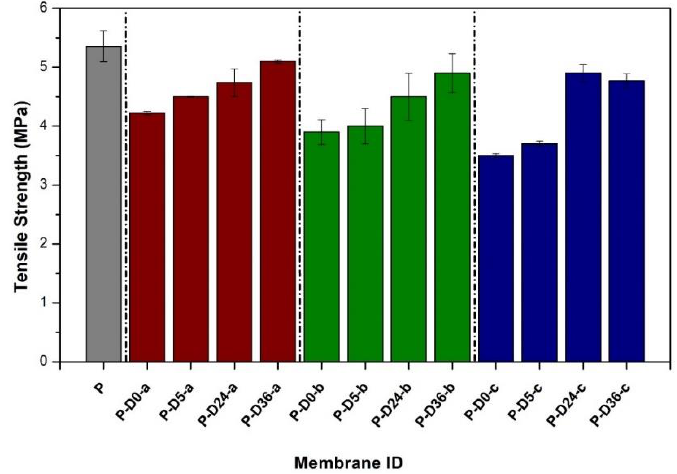
Figure 8. Tensile strength of original PES membranes and dopamine modified PES membranes at various concentrations and polymerization times. The data are presented as average ± standard deviation from n = 5.